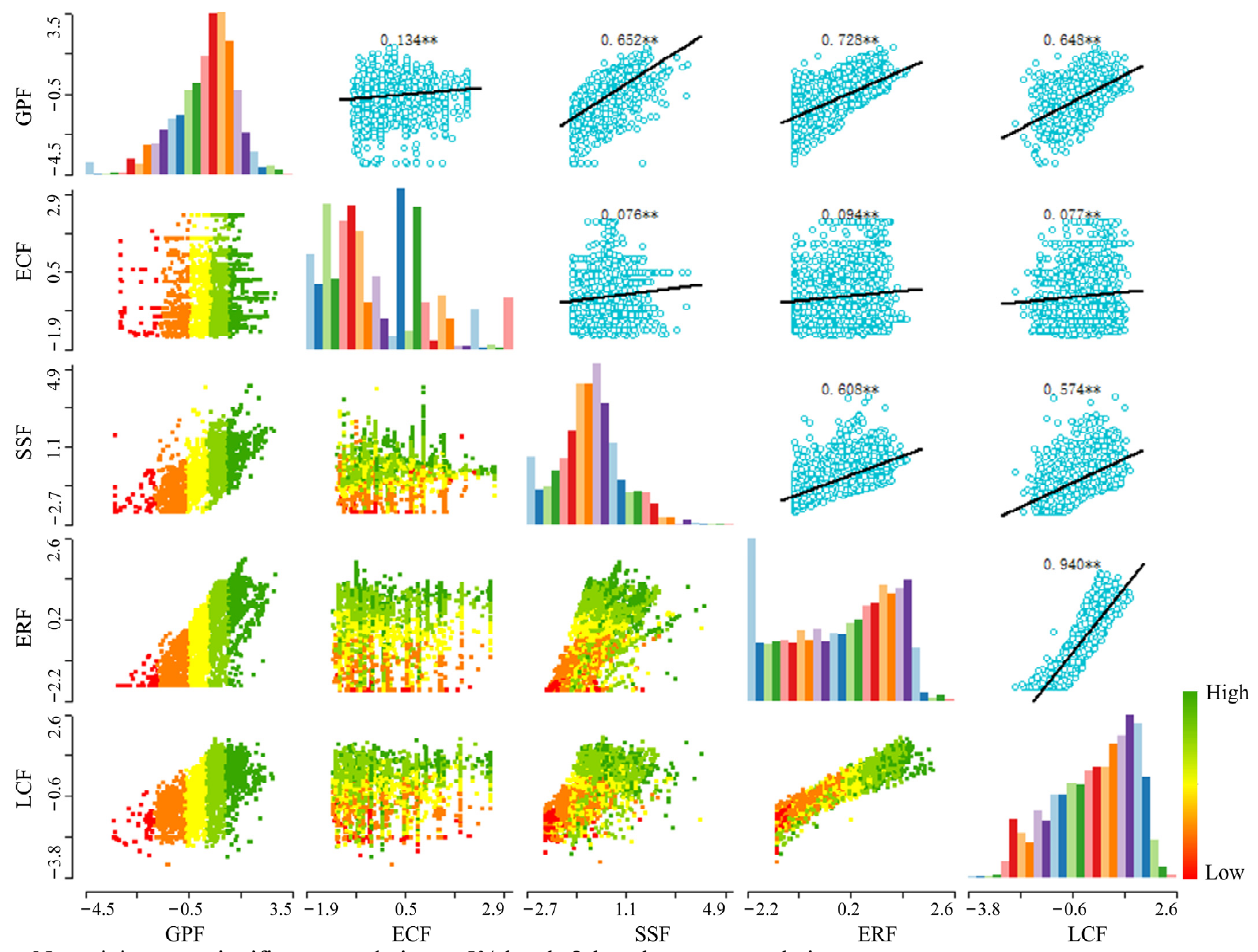
Figure 12. scatter diagram of multifunctional index matrix in two lake plains in 2019. Figure 12. Scatter diagram of multifunctional index matrix in two lake plains in